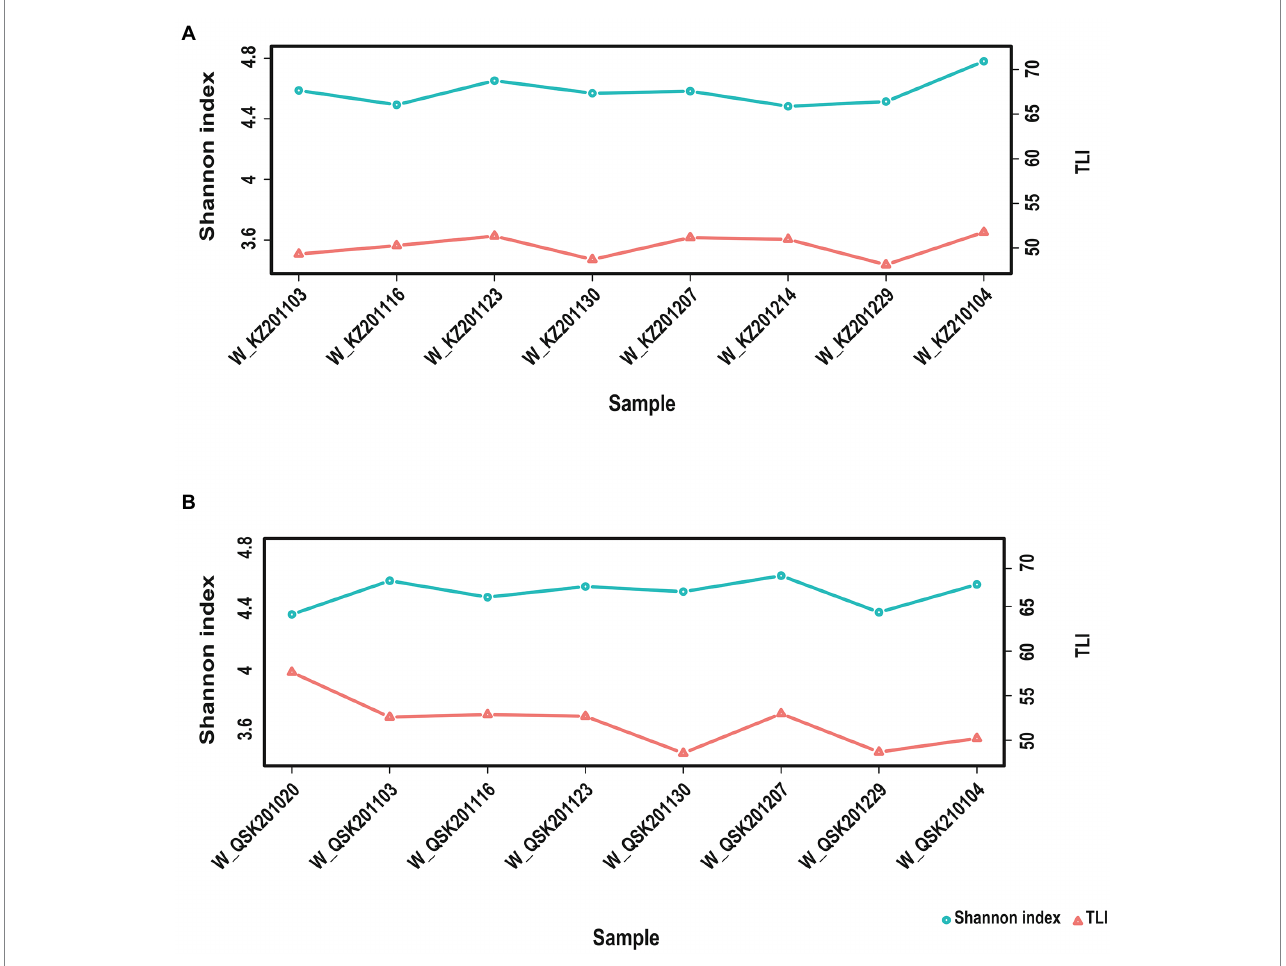
FIGURE 4 Relationships between TLI and the Shannon index. (A) KZ samples, (B) QSK samples.